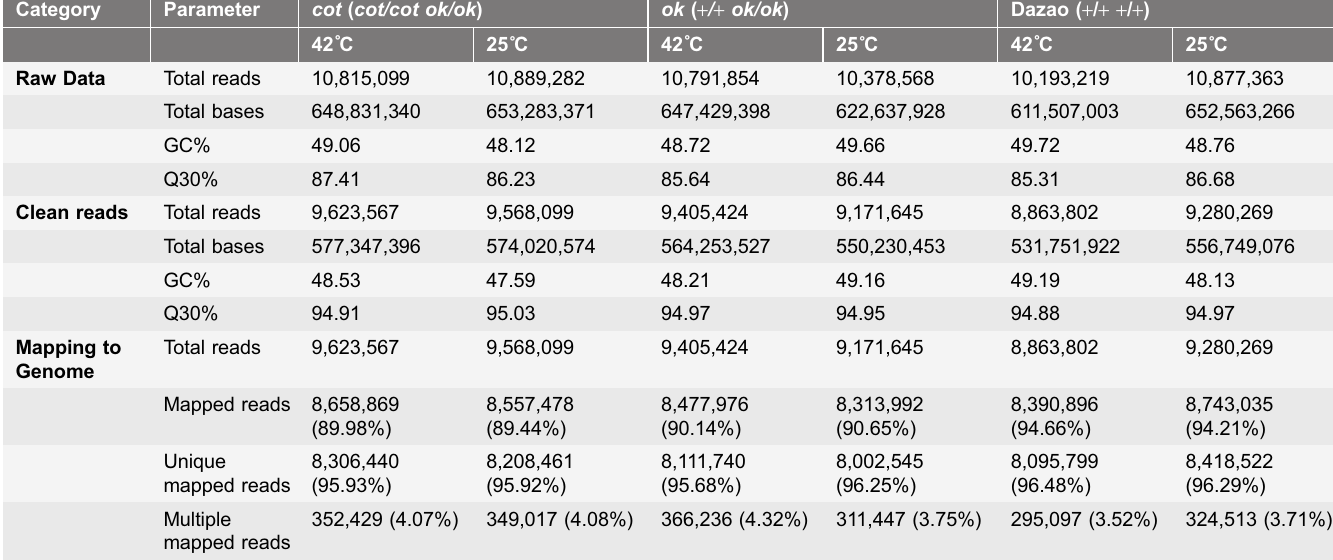
Table 1. Statistical analysis of transcriptome sequencing